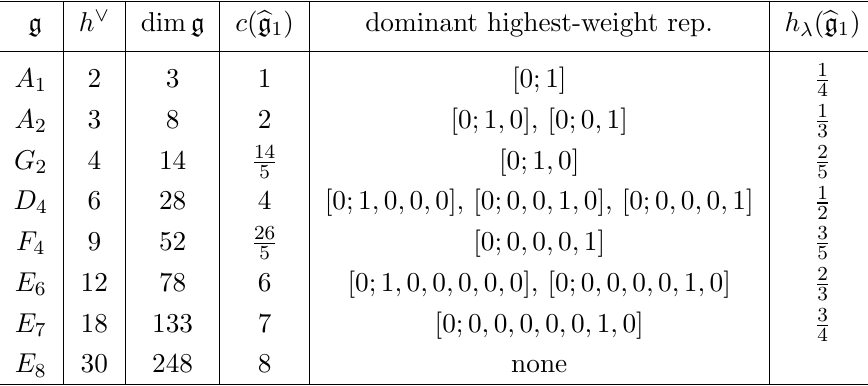
Table 1. Dual Coxeter numbers, dimensions, central charges c ( g k =1 ), dominant a(cid:14)ne weights of b g k =1 other than the basic weight [1; 0 ; 0 ; : : : ; 0], and conformal weights of corresponding primary